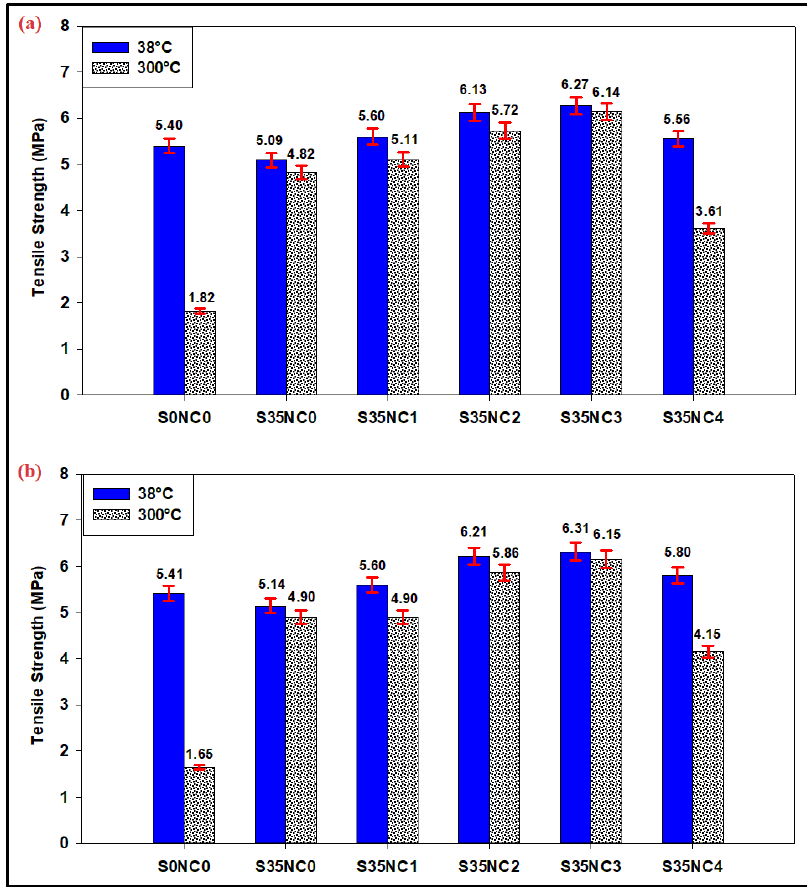
◦ C and 300 ◦ C after ( a ) 7 days ( b ) 28